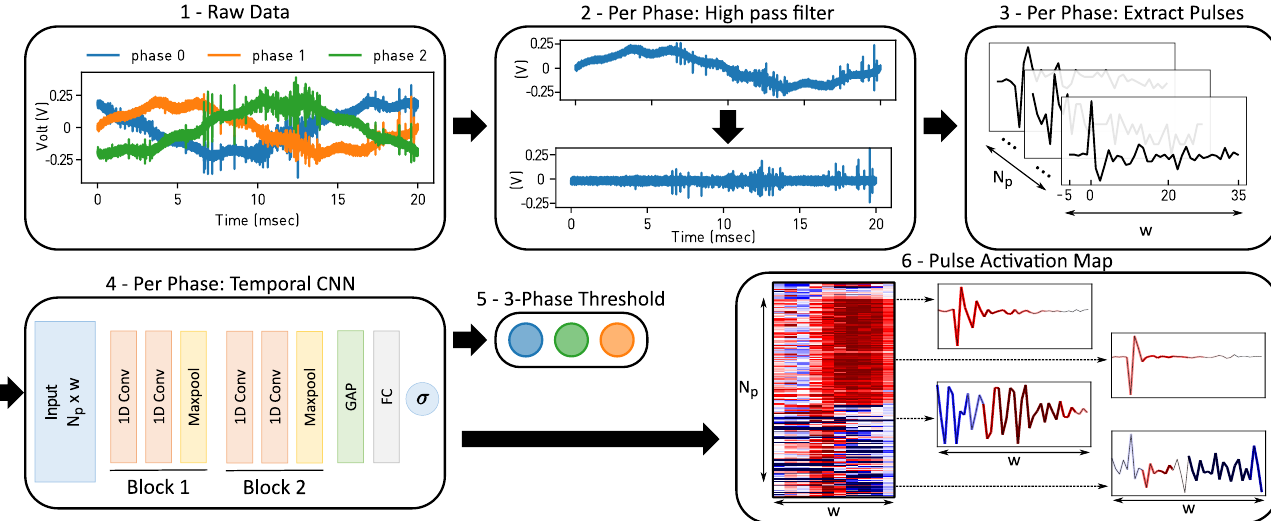
Figure 1. Graphical Abstract: ( 1 ) The raw data: three phases over one period. ( 2 ) For each phase, the signal is filtered to remove the utility frequency f ut . ( 3 ) Extracted w samples of pulses identified with a maximum filter. The windows start 1/8th before the identified peak. ( 4 ) For each phase, the pulse collection is fed to a deep 1D convolution neural network. ( 5 ) The outputs of the three phases are considered together to label the powerline. ( 6 ) Thanks to the Global Average Pooling (GAP) Layer, the Pulse Activation Map can be displayed for further